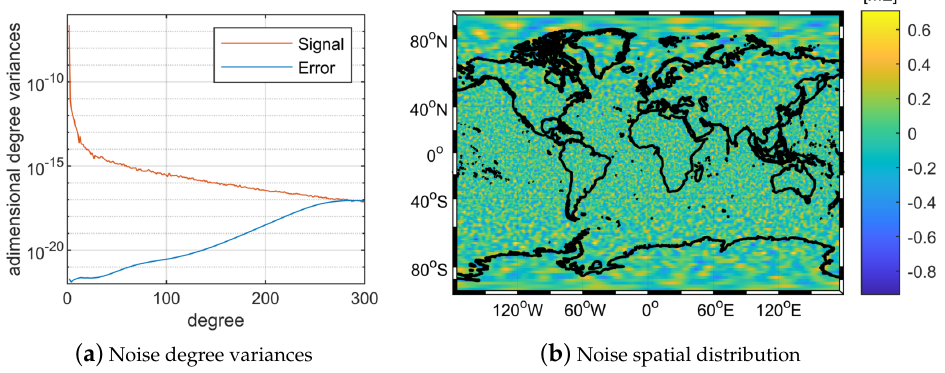
Figure 7. Noise of the simulated gravity signal in terms of second radial derivative.